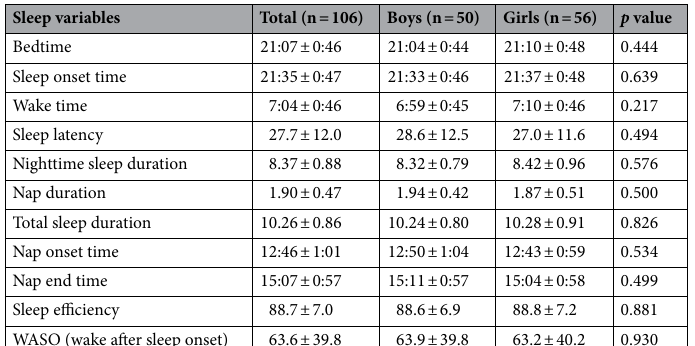
Table 3. Sleep variables (mean ± s.d.).